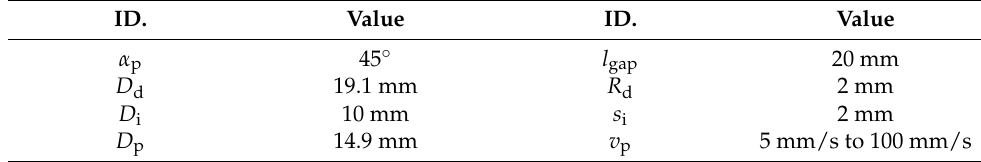
Table 3. Characteristic values of the hot hole-flanging